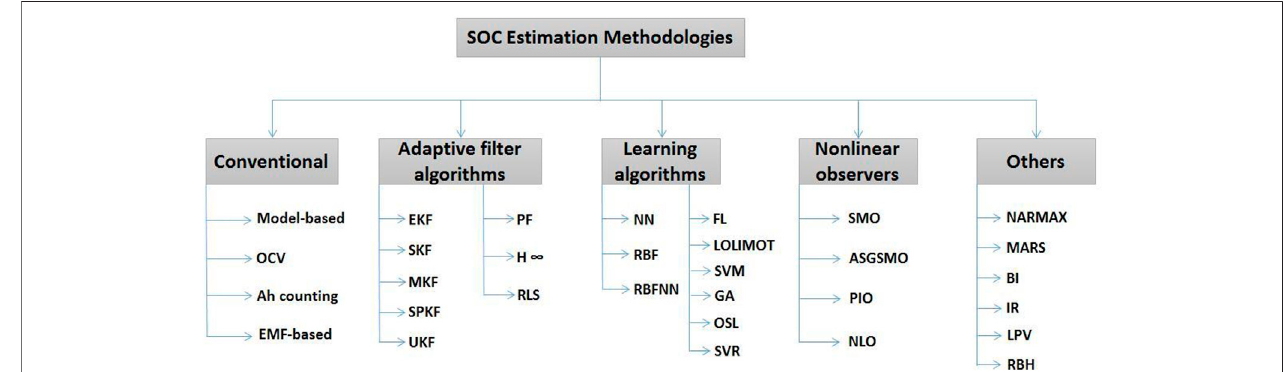
FIGURE 1 | Categorization of SOC estimation